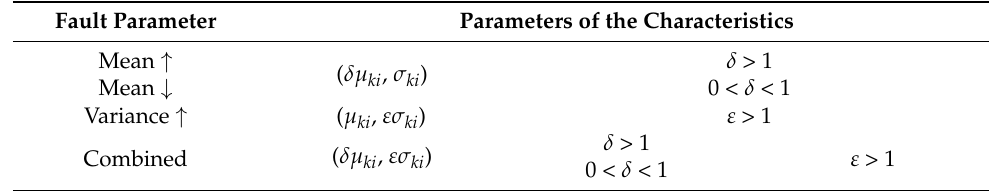
Table 2. Fault patterns of MP parameters. (“ ↑ ” means increase, “ ↓ ” means decrease). Fault Parameter Parameters of the Characteristics Mean